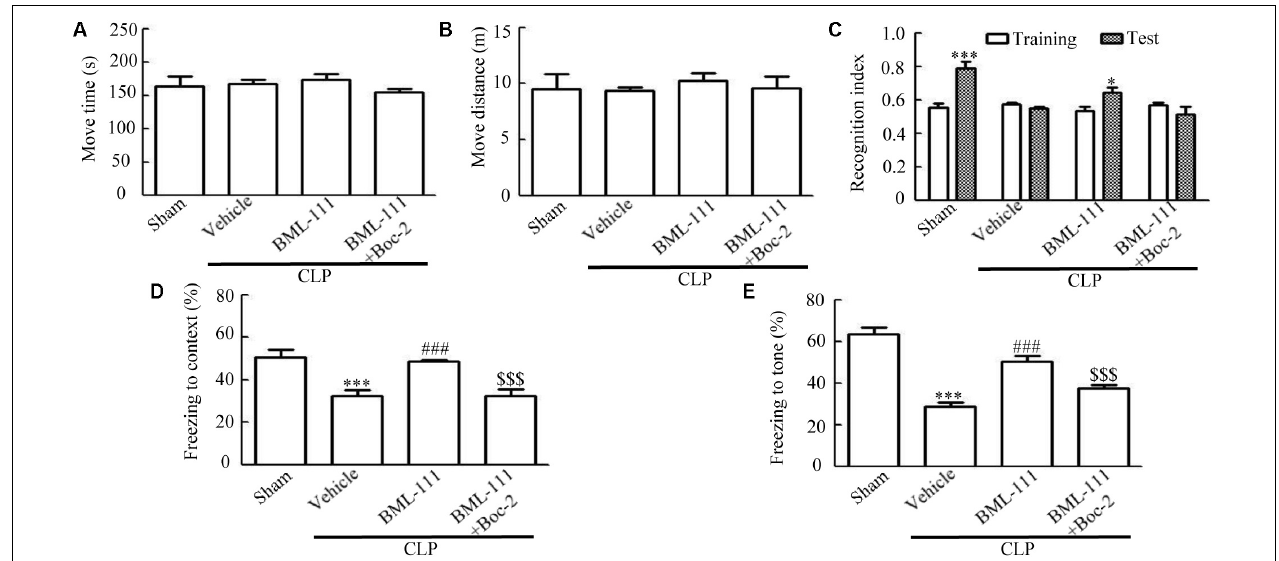
FIGURE 3 | BML-111 treatment reduces cognitive dysfunction in mice with sepsis. (A,B) The move time and distance in the open-field test did not differ among the four groups. (C) Sepsis did not result in the recognition index for the new object differing from that for the familiar one, whereas that for the new object in the sham group differed significantly from that for the familiar one. BML-111 treatment reversed the decrease in the recognition index in the CLP mice, and Boc-2 inhibited the effects of BML-111. (D,E) The freezing times in the contextual and tone-conditioning tasks were significantly decreased in the CLP + vehicle group compared with the sham group. BML-111 treatment reversed this decrease, and Boc-2 suppressed the effects of BML-111. Data were shown as the means ± SEM ( n = 10 surviving mice per group). ∗ P < 0.05, ∗∗∗ P < 0.001 represent Test vs. Training in C . ∗∗∗ P < 0.001 represents CLP + Vehicle vs. Sham, ### P < 0.001 represents CLP + BML-111 vs. CLP + Vehicle, $$$ P < 0.001 represents CLP + BML-111 + Boc-2 vs. CLP + BML-111 in (D,E) .